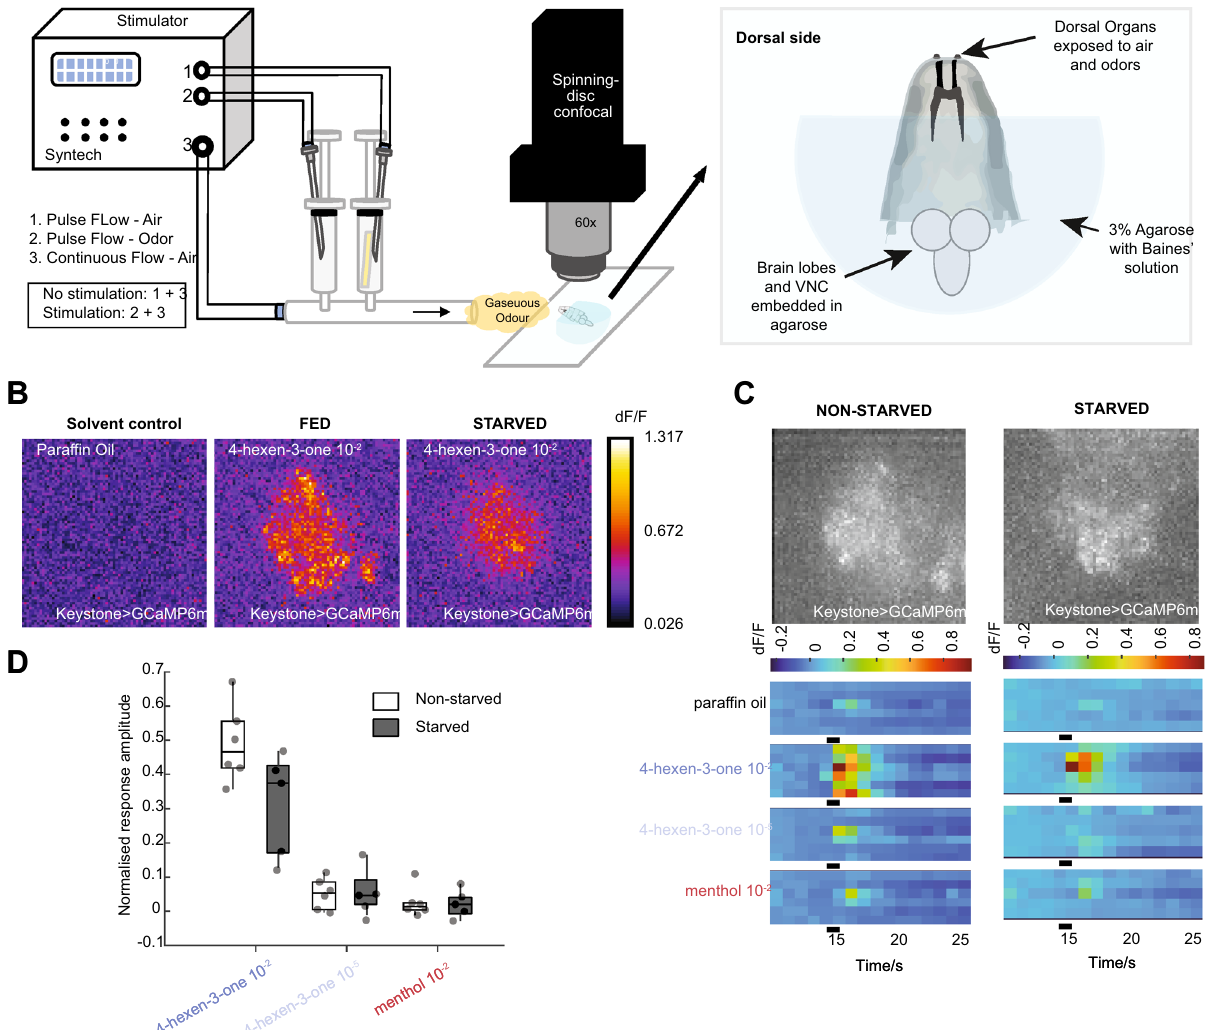
Figure 3. Odor responses of Keystone-LN in fed and starved larvae. ( A ). Schematic of in-vivo calcium imaging set-up. The odor stimulator consists of 3 air outlets, one for the carrier gas flow and two for the pulse flow. Under no stimulus conditions, airflow from outlets 1 and 3 are constant. When a stimulus is triggered, the airflow from outlet 1 is switched to outlet 2, which puffs air through an odor-containing syringe for 1 s, while carrier flow remains constant. Odor responses are recorded from the neurites of Keystones in the AL (Keystone- gal4; UAS-GCaMP6m) using a spinning disk confocal microscope. ( B ) Representative odor-evoked calcium responses in the neurites of Keystone-LNs to the indicated odors diluted in paraffin oil. ( C ) The top panels show maximum projection images of baseline GCaMP fluorescence in Keystone-LN neurites in the antennal lobe. The bottom heatmaps represent the responses of Keystone-LN neurites to the indicated odors under fed and starved conditions. Each row corresponds to responses from an individual larva. The black bar indicates when the 1-s odor stimulus was applied. ( D ) Box plots showing solvent corrected response amplitudes with min–max normalization (see “Methods”) comparing responses to different odors in fed and starved states. Mann–Whitney U -test was used to test differences between fed and starved conditions. No statistically significant differences were found for any of the odors